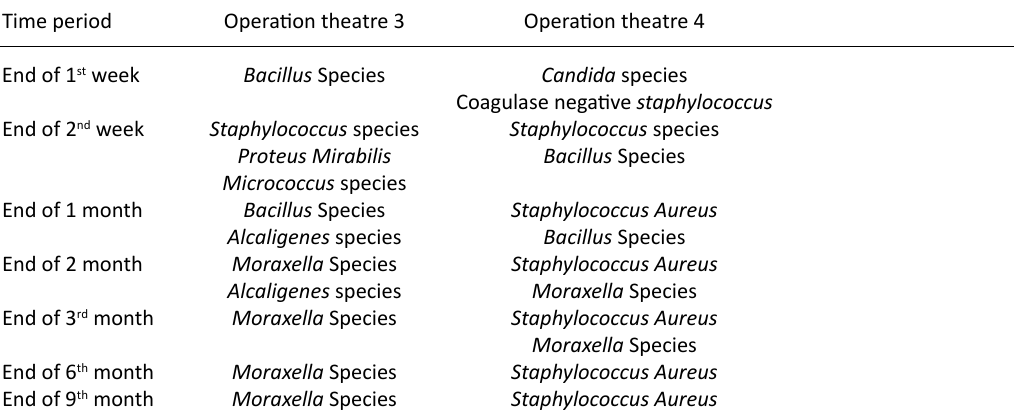
Table 1. Culture reports showing growth of various microbial floras at periodical interval Time period